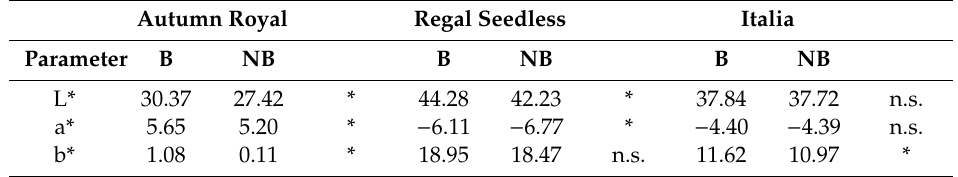
Table 3. Skin CIEL*a*b* color parameters, L*(Lightness), a*(red / green coordinate), and b*(yellow / blue coordinate), of bagged (B) and not bagged (NB) berry skin of the three table grape varieties.